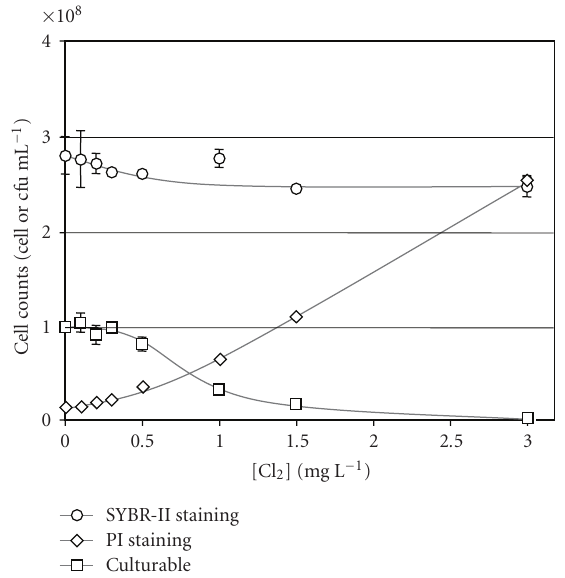
Figure 1: Numbers of CFU ( ), cells stained by Sybr-II ( ), and cells stained by PI ( ) versus initial applied [Cl 2 ] (mgL − 1 ) (22 ± 1 ◦ C) of Salmonella typhimurium